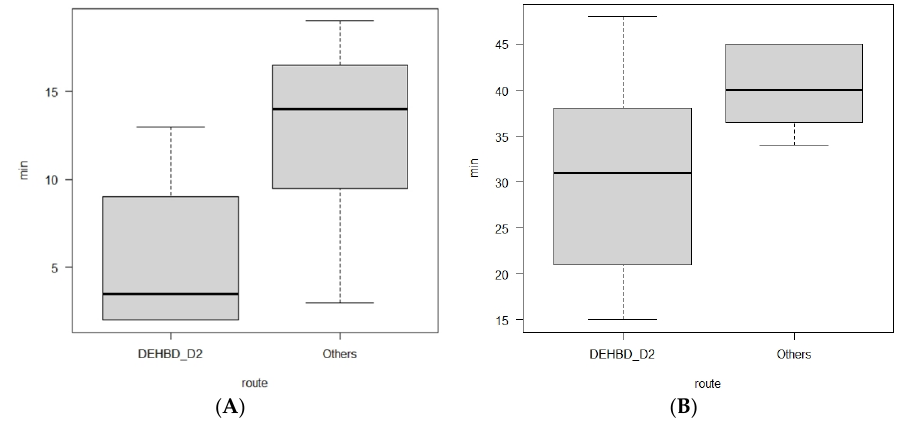
Figure 8. Box plots showing comparisons of procedural time between the DEBHD/D2 route and the others. The time from the puncture to the guidewire placement in the DEHBD/D2 route is significantly shorter than that in the others ( p = 0.014) ( A ). The time from echoendoscope insertion to cannulation in the DEHBD/D2 route is shorter than that in the others but not significant ( p = 0.07) ( B ). Bold horizontal lines inside boxes indicate median. Upper and lower sides of boxes indicate upper quartile and lower quantile, respectively. Short lines above and below boxes indicate maximum and minimum, respectively. DEHBD / D2: distal extrahepatic bile duct / duodenal second